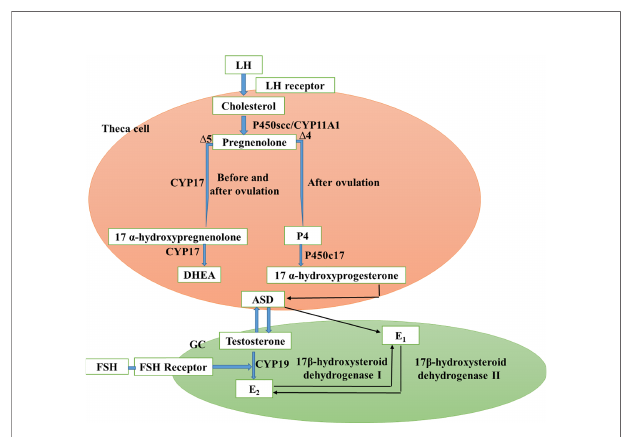
FIGURE 1 | Schematic representation of the PCOS ovarian hormones (Adapted and modi fi ed